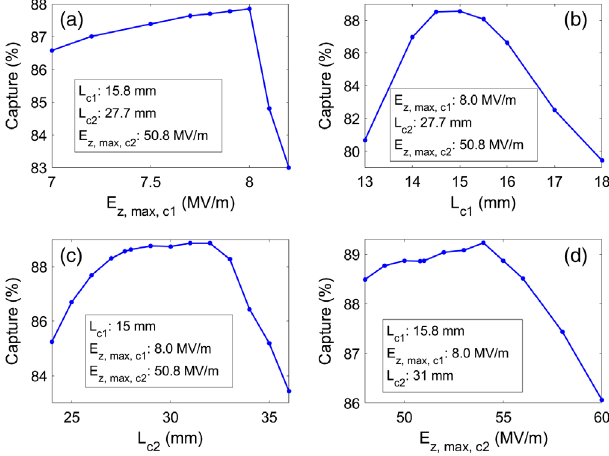
FIG. 12. Results of fine-tuning the cavity parameters using ASTRA .